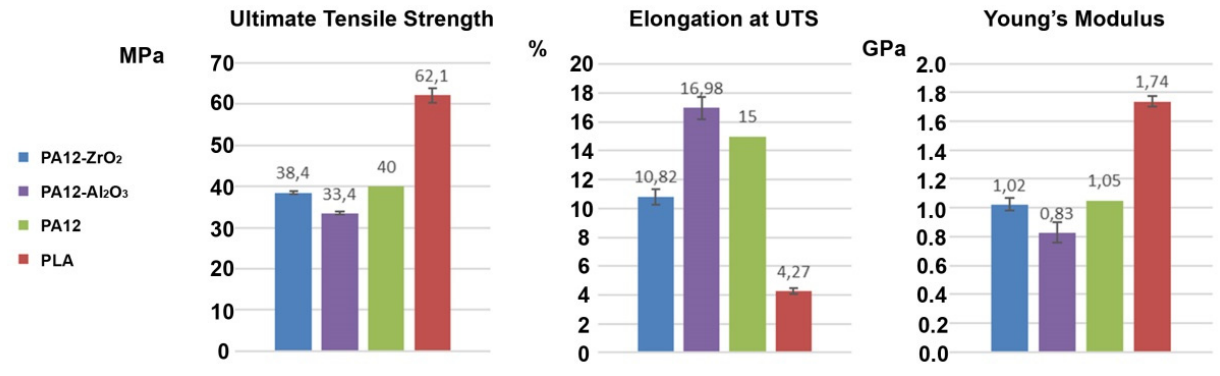
Figure 12. Ultimate tensile strength, elongation at ultimate tensile strength, and Young’s modulus of composite materials PA12-ZrO 2 , PA12-Al 2 O 3 , pure PA12, and PLA.